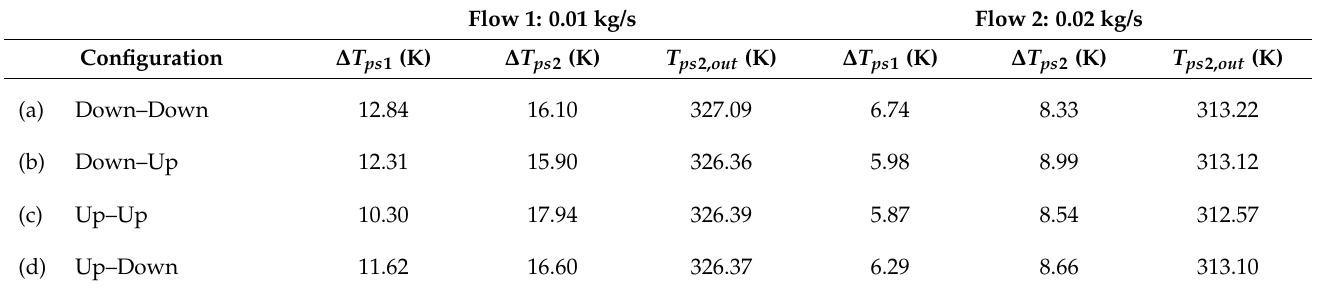
Table 8. U-shape double-pass CPC temperature increments and outlet temperature ( T f 1, in = 298.15